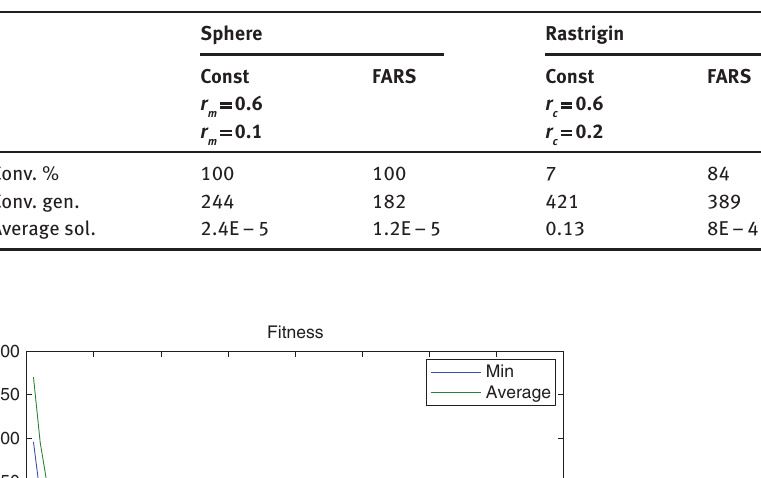
, r ) Combination for the Constant Approach is c m